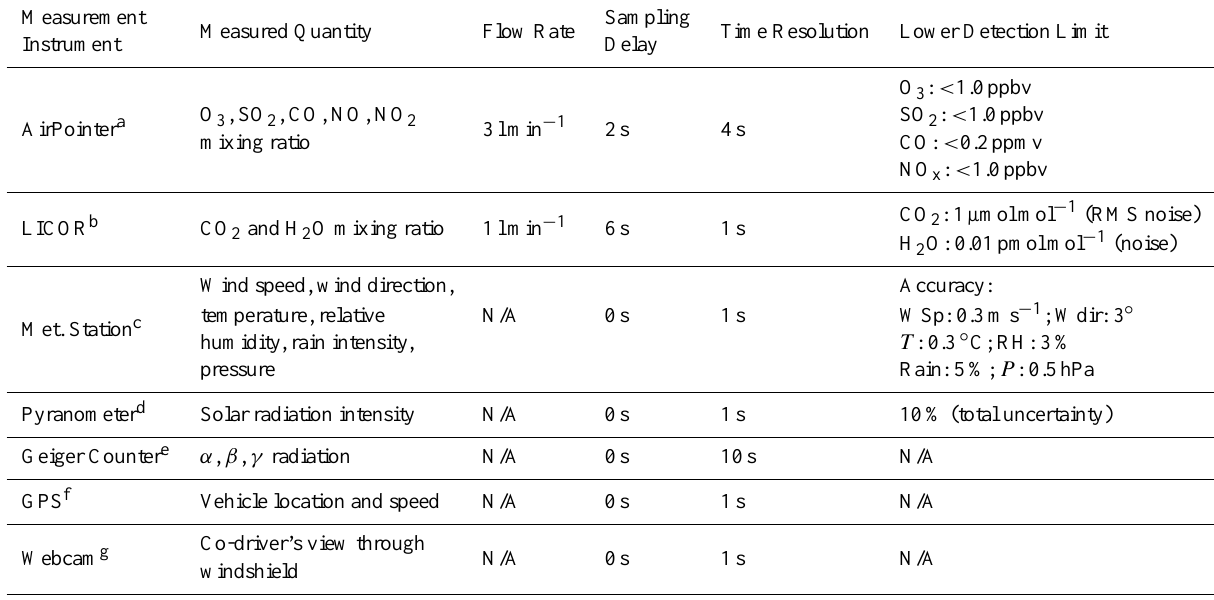
Table 2. Summary of non-aerosol measurement instruments in the mobile laboratory MoLa with various instrument details. The sampling delay is the time the measurement is performed after the actual occurrence of the ambient feature, calculated for the roof inlet with 6m sampling